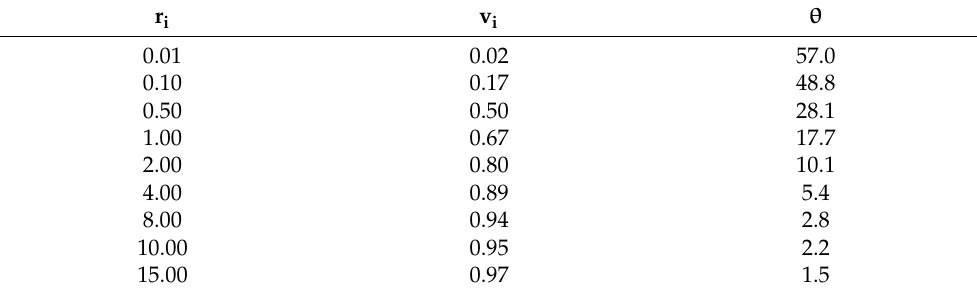
Table 1. The calculated velocity and angle values, in order for the vehicle to turn fluently, for a given initial velocity and turning